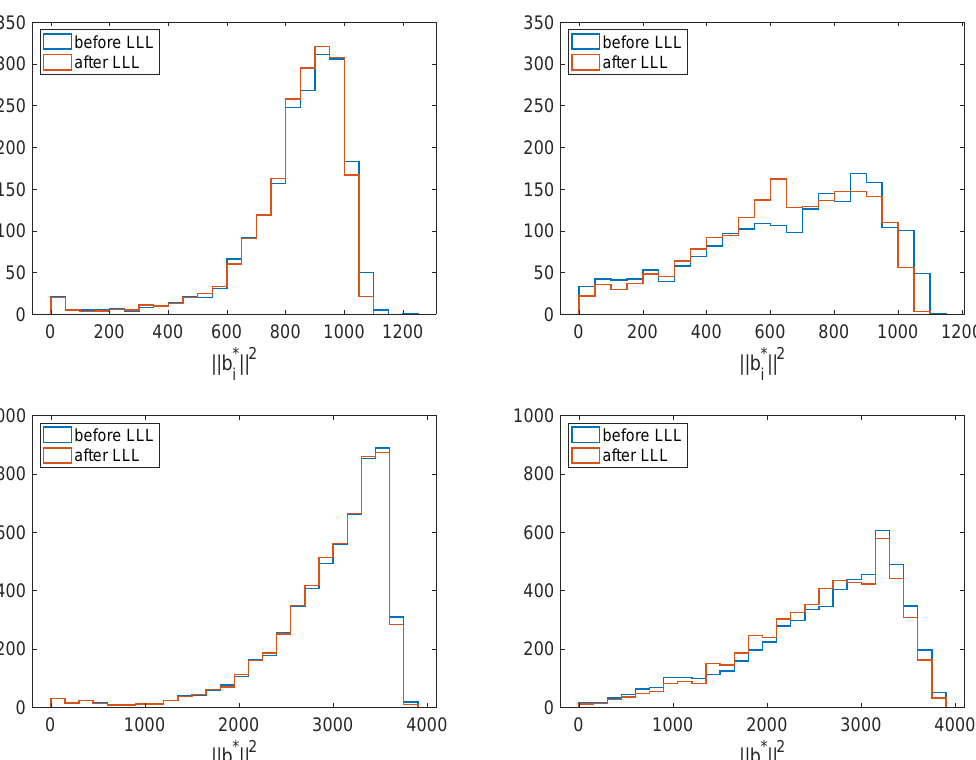
Figure 11: Histograms of the squared lengths of Gram-Schmidt orthogonalized ba- sis vectors b ∗ before and after the LLL reduction for (top left) a chaotic realiza- i tion at ( N , M ) = ( 25,25 ) with D = 1958, (top right) truncated Szeg˝o system at ( N , M ) = ( 25,25 ) , (bottom left) a random quantum resonant Hamiltonian at ( N , M ) = ( 30,30 ) with D = 5604, (bottom right) truncated Szeg˝o system at ( N , M ) = ( 30,30 ) . The locality threshold was chosen as k = 6 in all four plots. One observes that the LLL basis reduction is more significant for the integrable model shown on the right than for the chaotic models on the left. This distinction di- rectly impacts the corresponding complexity curves, since the estimate (3.23) for the plateau value is proportional to the average of the lengths of the Gram-Schmidt vectors, and leads to stronger complexity reduction for integrable models, as seen in Fig. 7 and Fig.